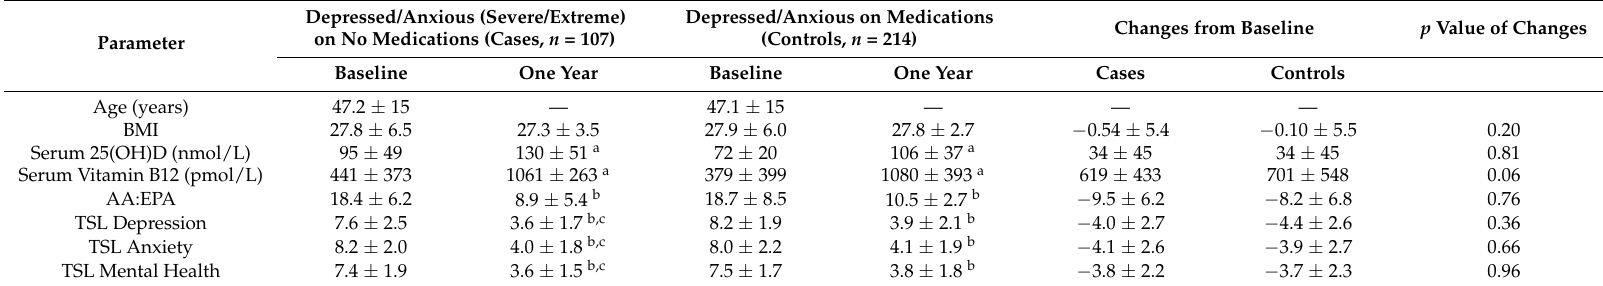
Table 8. Comparison of biomarkers of nutrition and mental health scores between case and control